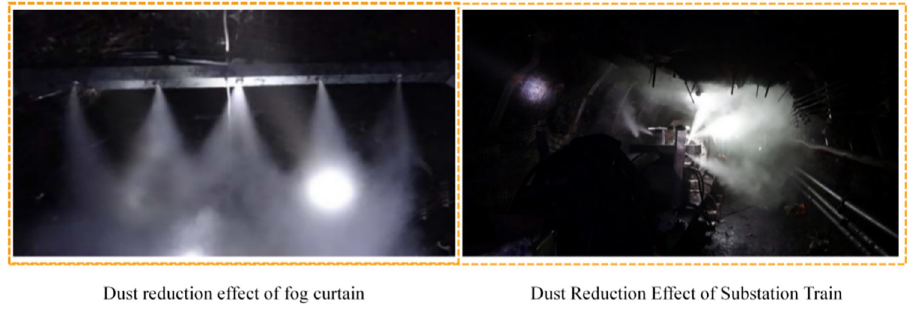
Fig 13. Site treatment